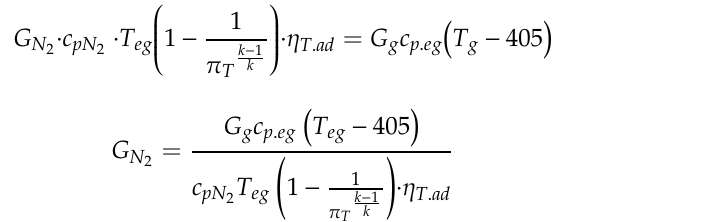
Table 3. The results of boundary nitrogen flow boundary G N